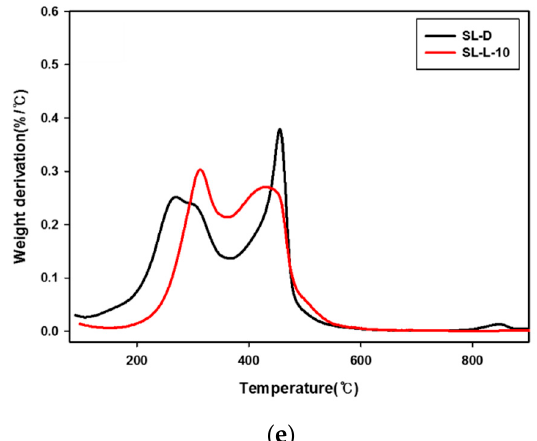
Figure 2. DTG curves of combustion behaviors: ( a ) lignin/toreffied lignin at 250 °C (lignin-250) samples; ( b ) SW-D/SW-L-10/torrefied SW (SW-250) 90% torrefied lignin (lignin-250) 10% blending samples; ( c ) SW-D/SW-L-10/SW-L-20/SW-L-30 samples; ( d ) DS-D/DS-L-10; and ( e ) SL-D/SL-L-10 samples.